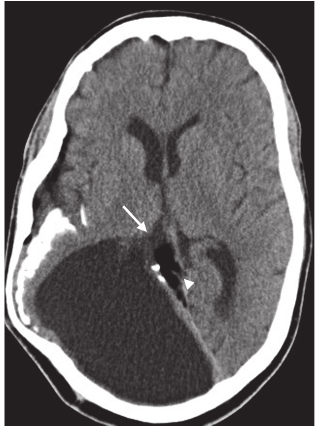
Figure 1: Noncontrast CT bone windows. Fracture of right parietal bone (arrow). Cortical gyriform calcifications are seen (arrowhead).